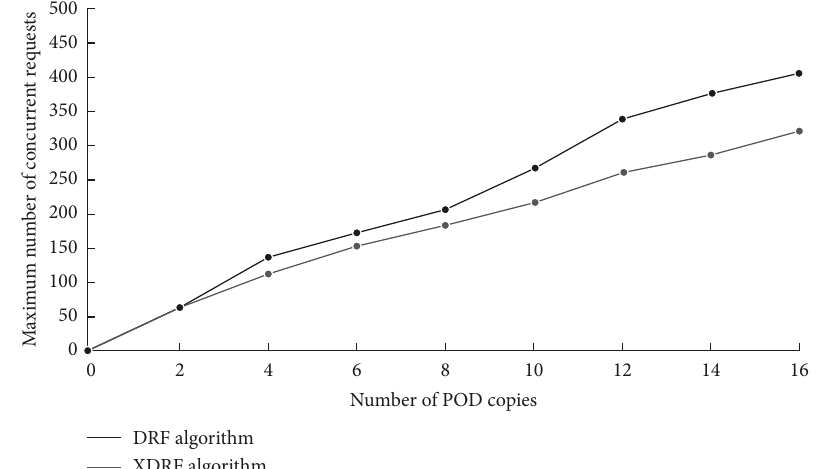
Figure 3: The relationship between the maximum number of XEDI concurrent requests and the number of POD